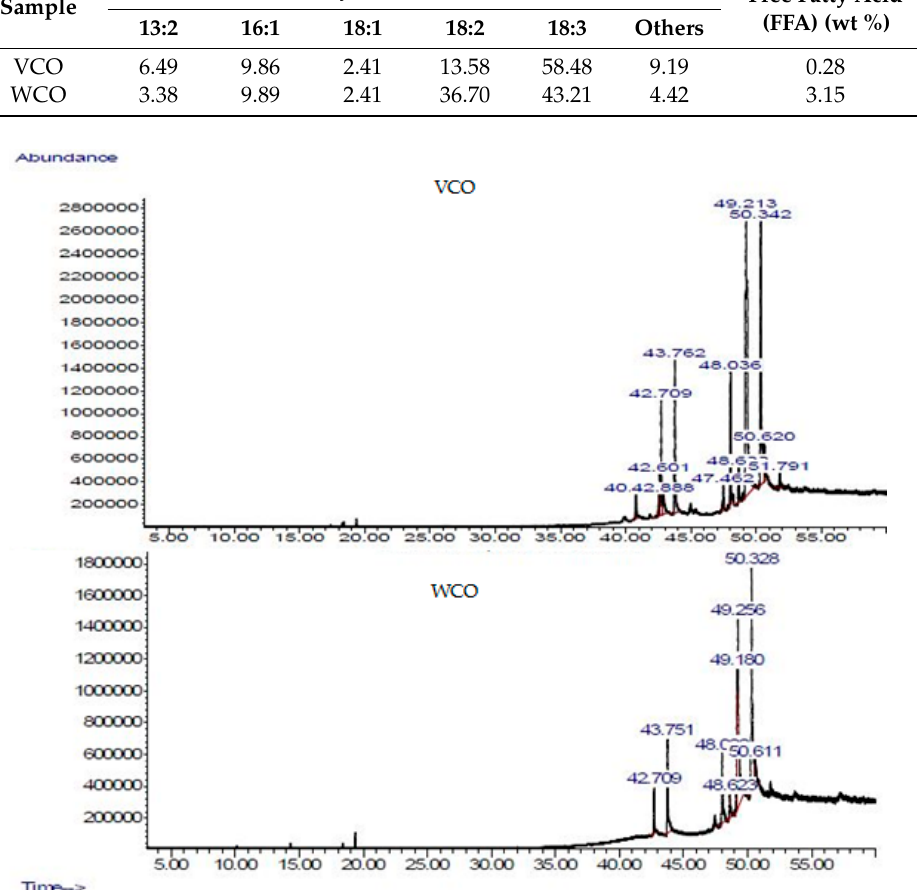
Figure 2. GC chromatogram of VCO and WCO used as raw material.